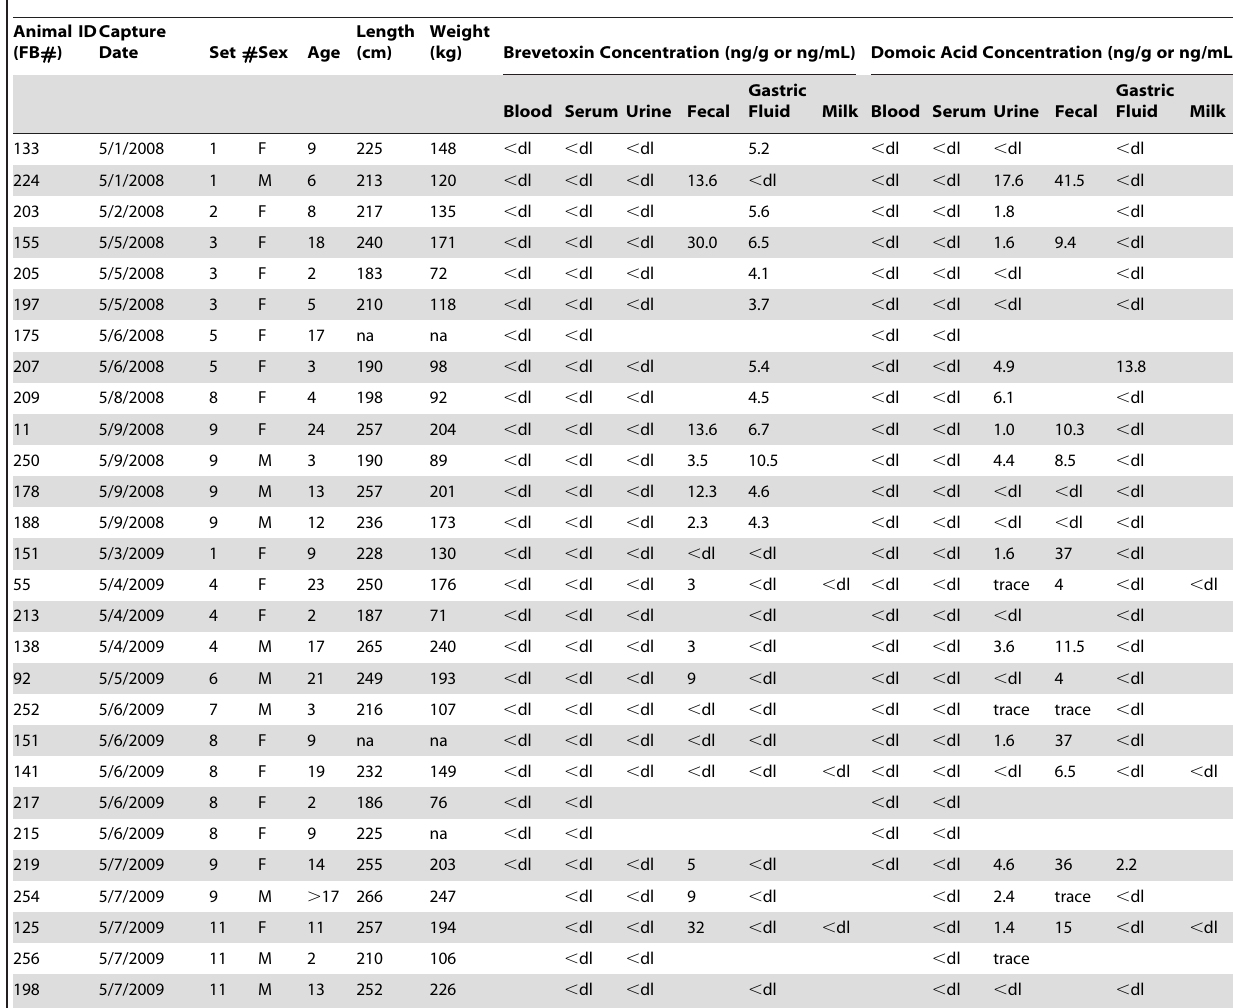
Table 1. Animal information and biotoxin tissue/fluid concentrations for the bottlenose dolphins ( Tursiops truncatus ) sampled during the May 2008 and 2009 health assessments in Sarasota Bay,